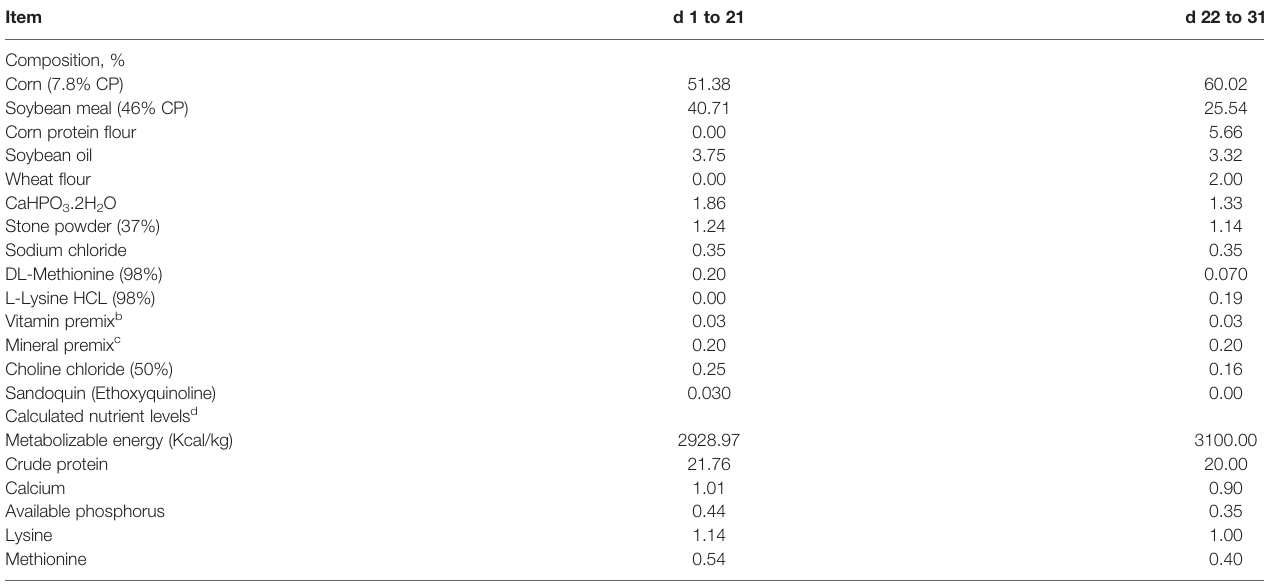
TABLE 1 | Ingredients and composition (calculated and analyzed nutrients) of the experimental diets a (%, unless otherwise noted, as-fed basis). Item d 1 to